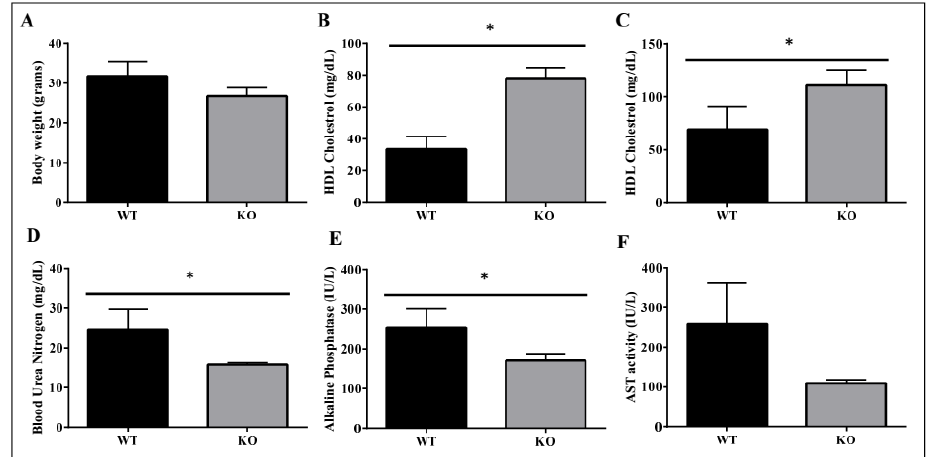
Figure 10. Metabolic benefits in female ADAM28 knock-out (KO) mice. Body weight at 10 months of age ( A ); High-density lipoprotein (HDL) cholesterol at 49 days of age ( B ); HDL cholesterol at 6 months of age ( C ); Blood urea nitrogen at 49 days of age ( D ); Alkaline Phosphatase at 49 days of age ( E ) and AST activity at 49 days of age ( F ). * p < 0.05; n = 3–4 mice/group.